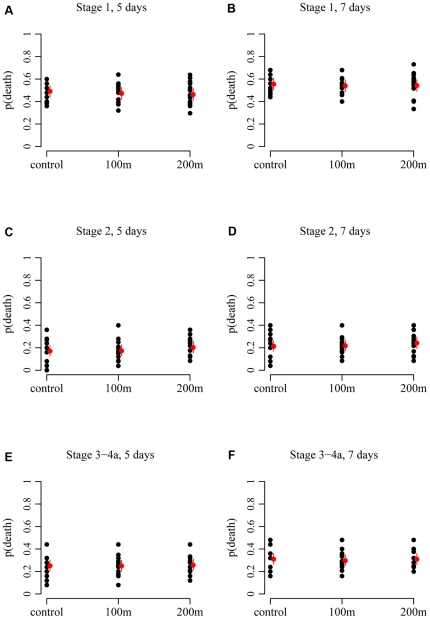
Mortality by larval stage and treatment at 5 and 7 days after the treatment.Estimated mean probability of death with 95% confidence limits (red symbols and bars) and observed mortality for each replicate within each treatment (black symbols). Each replicate consisted of 25 (±5) larvae. The labels of the sound exposure treatments refer to the distance from the pile, the associated sound levels are presented in Table 3.